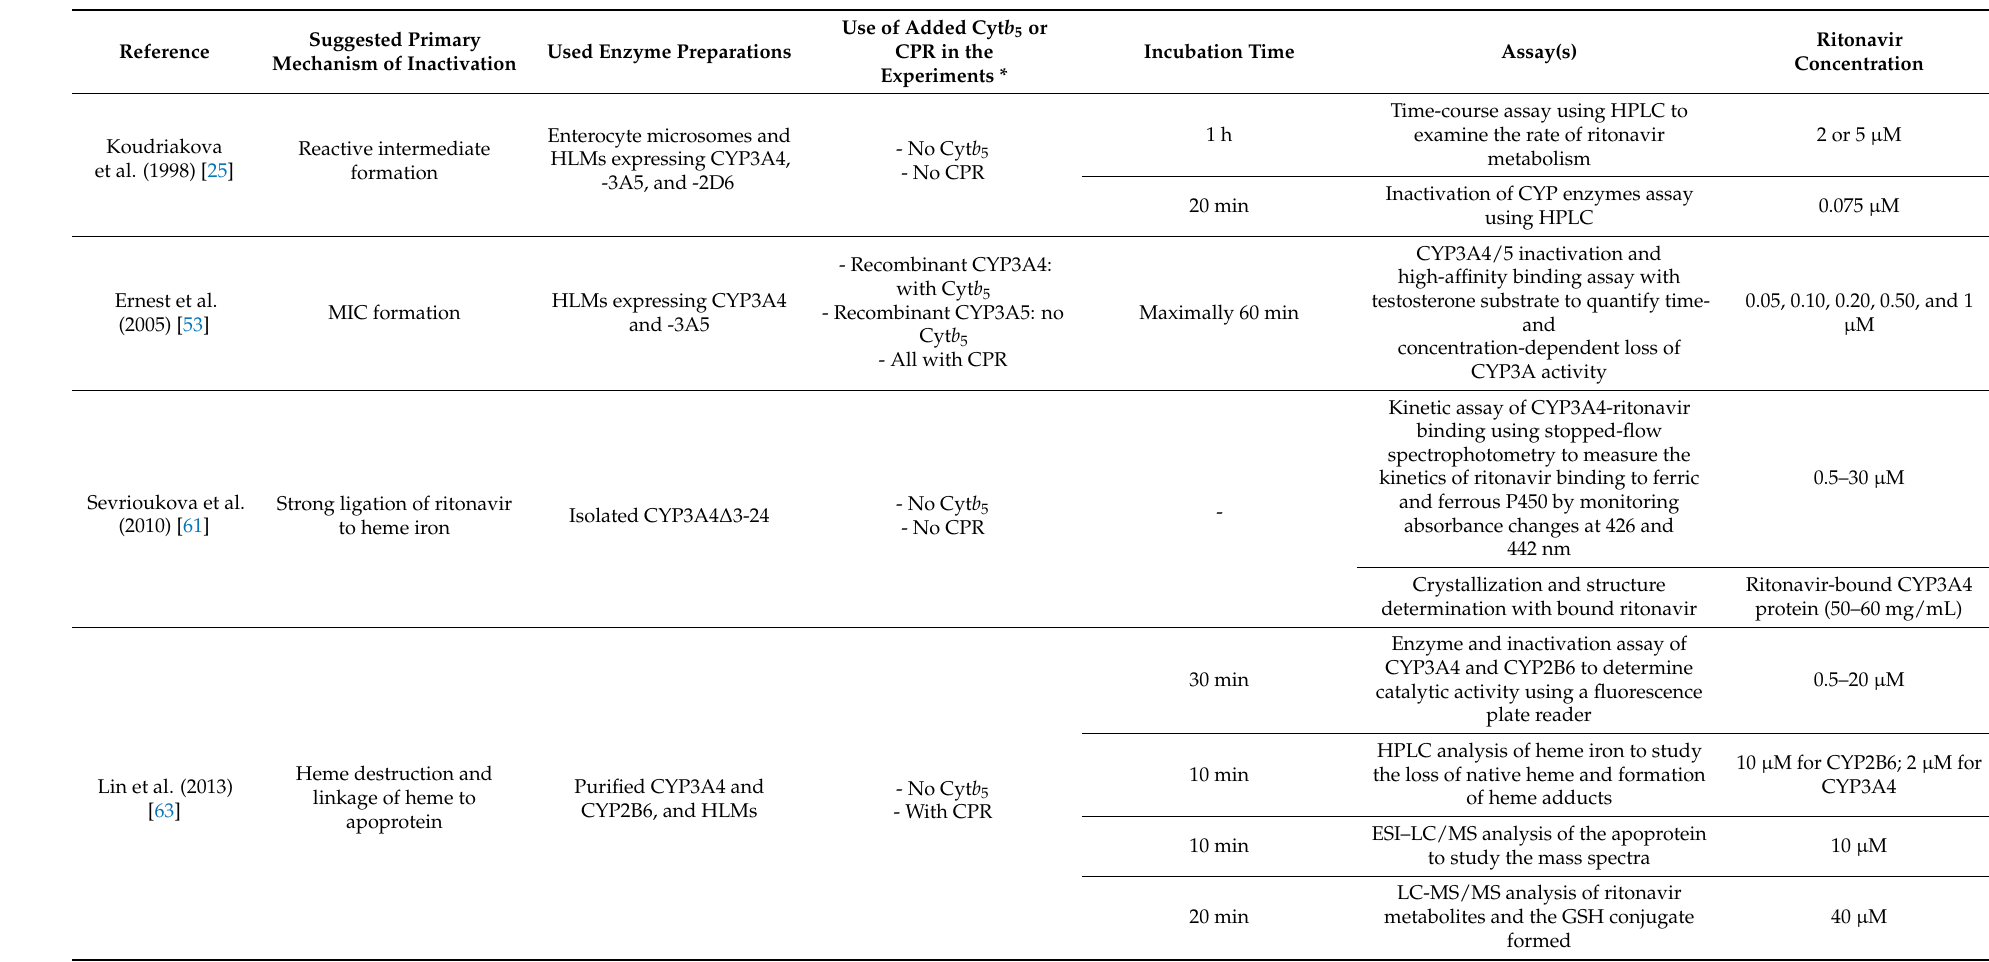
Table 1. Systematic overview of the divergent proposed mechanisms of mechanism-based inactivation of CYP3A by ritonavir and the used experimental